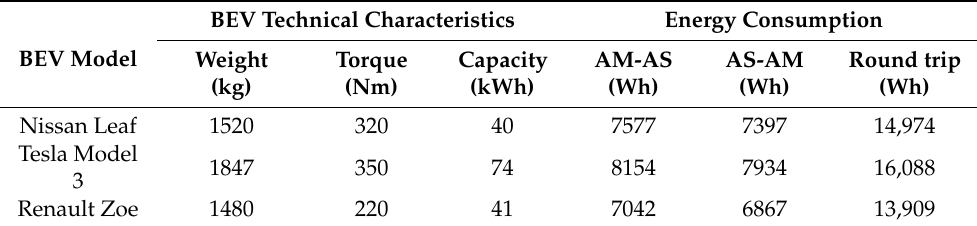
Table 2. Energy consumption for the long-distance route.